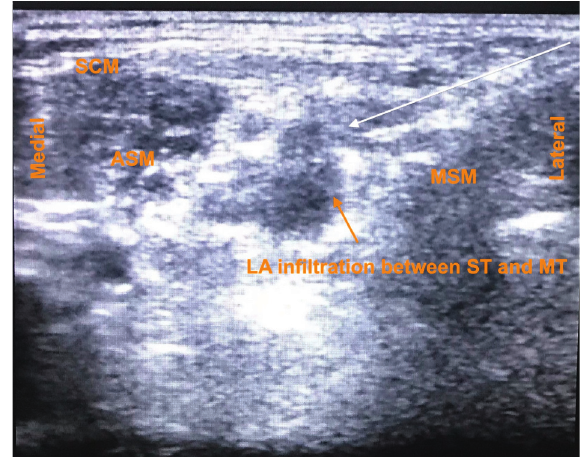
Figure 3: Local anesthesia spread around the brachial plexus trunk with needle. Arrow indicates needle direction. Abbreviation: ASM, anterior scalene muscle; LA, local anesthesia; MSM, middle scalene muscle; MT, middle trunk; ST, superior trunk; SCM, sternocleidomastoid